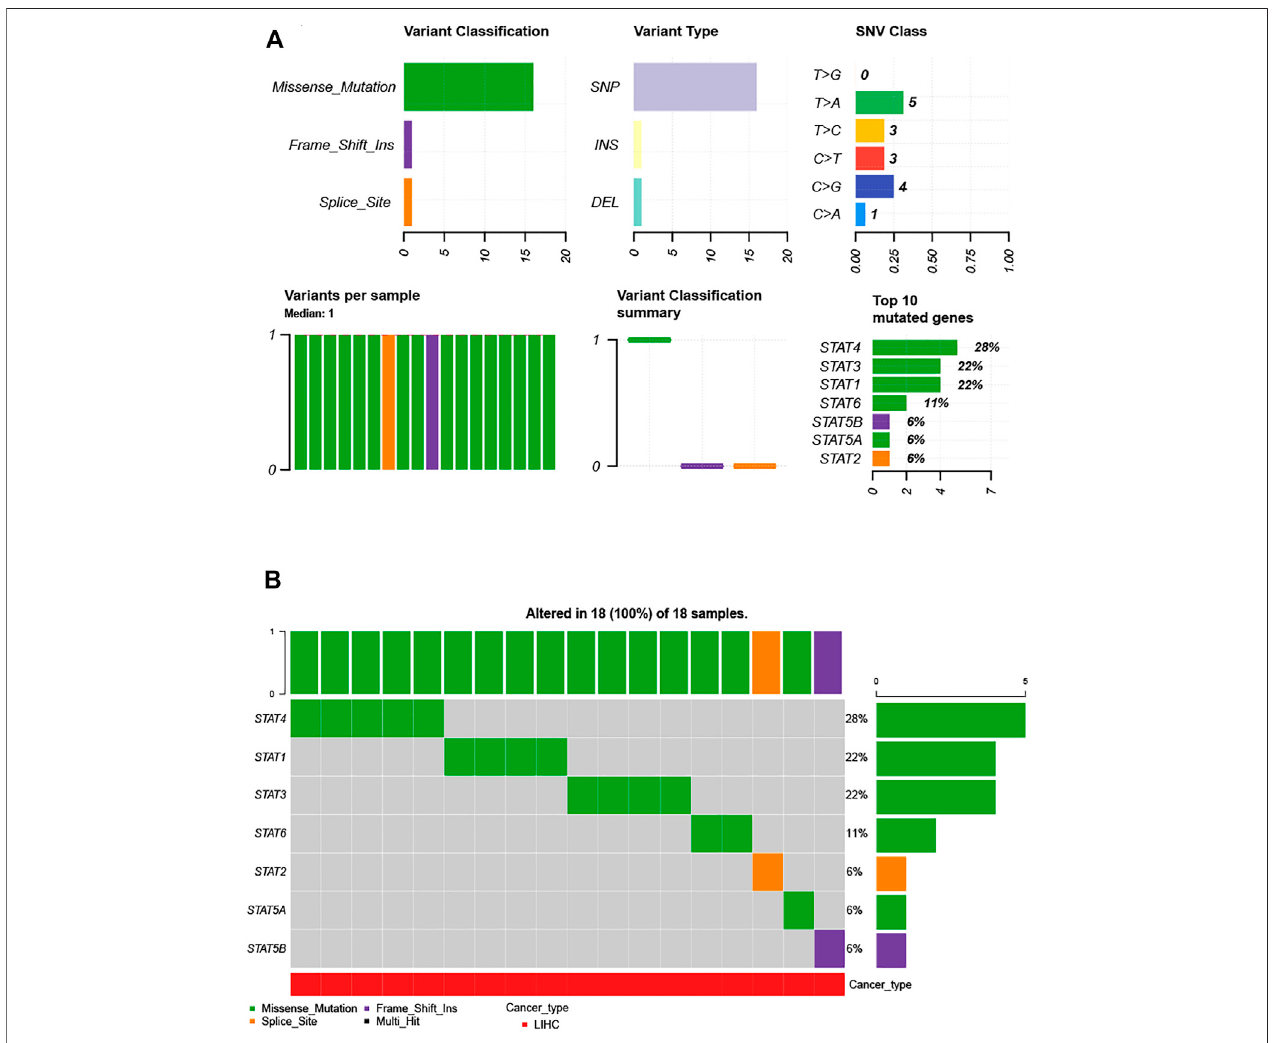
FIGURE 3 | Single-nucleotide variation (SNV) analysis of the STAT family in HCC (GSCALite). (A) Summary plot displaying SNV frequency and variant types of the STAT family in HCC, and genetic alterations of the STAT family constitute SNPs, insertions, and deletions. (B) Waterfall plot shows the mutation distribution of the STAT family in HCC, and STAT4 (28%), STAT3 (22%), and STAT1 (22%) were the top three most frequently mutated genes among all STAT family members.